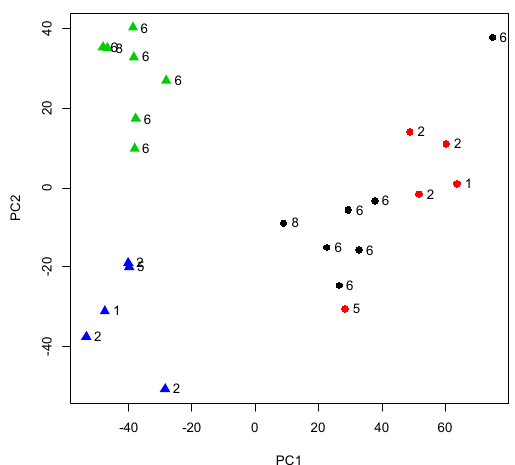
Figure 1. Transcriptomic profile of the Hanwoo muscle at different ages. Principal component analysis (PCA) on log 2 cpm in Hanwoo’s muscle at 18 months (circle) and 30 months (triangle) of age. The numbers indicated the marbling score (recorded at 30 months) while the colors correspond to the MS grouping (High: black and green; Low: red and blue). From the five contrasts used to compare transcriptomic differences, in total we found 1883 DE genes (adjusted p -value < 0.05 and log 2 FC > 1.5), among them, 782 genes were up-regulated and 1101 down-regulated (Figure 2A). The lowest number of DE genes was five, identified in the contrast 18: Low vs. High, followed by 228 DE genes from the 30: Low vs. High contrast (187 down-regulated and 41 up-regulated genes). More DE genes were found when contrasting expression at different ages, 682 DE genes were the highest number of genes found in the Low: 18 vs. 30 contrast, followed by 511 DE genes found in High: 18 vs. 30 (Figure 2A). The Venn diagram shows the number of differentially expressed genes overlapped between the contrasts. Only five genes were found shared by 30: Low vs. High, Low: 18 vs. 30, High: 18 vs. 30, and 18 vs. 30 contrasts (Figure 2B). From these genes, SCO-spondin ( SSPO ) and the miR-208b (Bta-mir-208b) were up-regulated in High MS, while Midkine ( MDK ), novel gene (ENSBTAG00000003152), and Fibrillin 3 ( FBN3 ) were down-regulated in steers with High MS. There were 2, 6, 117, 124, and 326 DE genes uniquely found in 18: Low vs. High, 18 vs. 30, High: 18 vs. 30, 30: Low vs. High, and Low: 18 vs. 30, respectively (Figure 2B). These findings indicate that depending on the marbling group (high or low), there are genes differentially expressed exclusively found between 18 and 30 months.